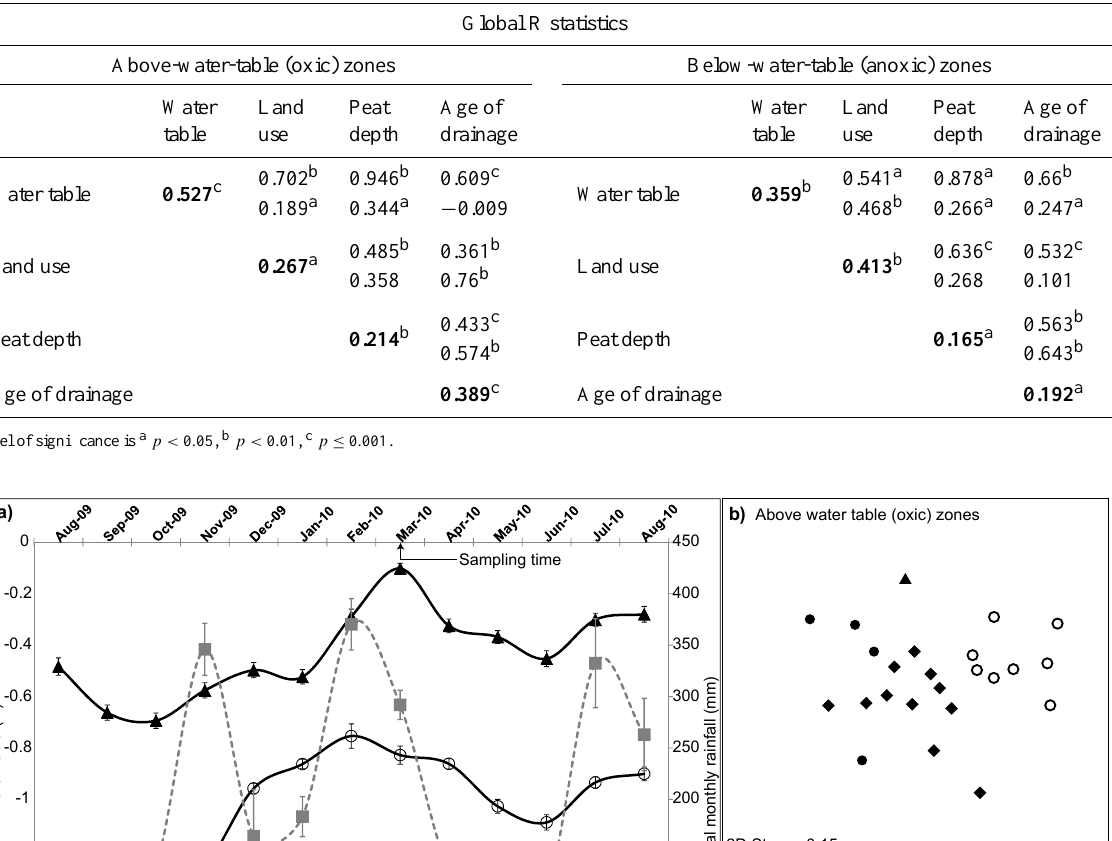
Table 2. One-way (bold letters in diagonal cells) and Two-way (non-bold letters in off-diagonal cells) ANOSIM showing variation in bacterial community structure due to an individual parameter across other parameters tested in oxic and anoxic zones. The top value in each white cell refers to influence by the individual parameter across others (left to right), whereas the bottom value in the same white cell shows the converse (right to left). Values in white cells can be directly compared within same white cells or between white cells of oxic and anoxic zones. As an example of within-white cell comparison: in oxic zones, the influence of water table was much higher across different land-use patterns (global R: 0.702), peat depth (0.946) and age of drainage (0.609) than vice versa (0.189, 0.344, NS: − 0.009), respectively. However, in anoxic zones, land-use pattern had high influence across water table (0.468), peat depth (0.636) and age of drainage (0.532), respectively.